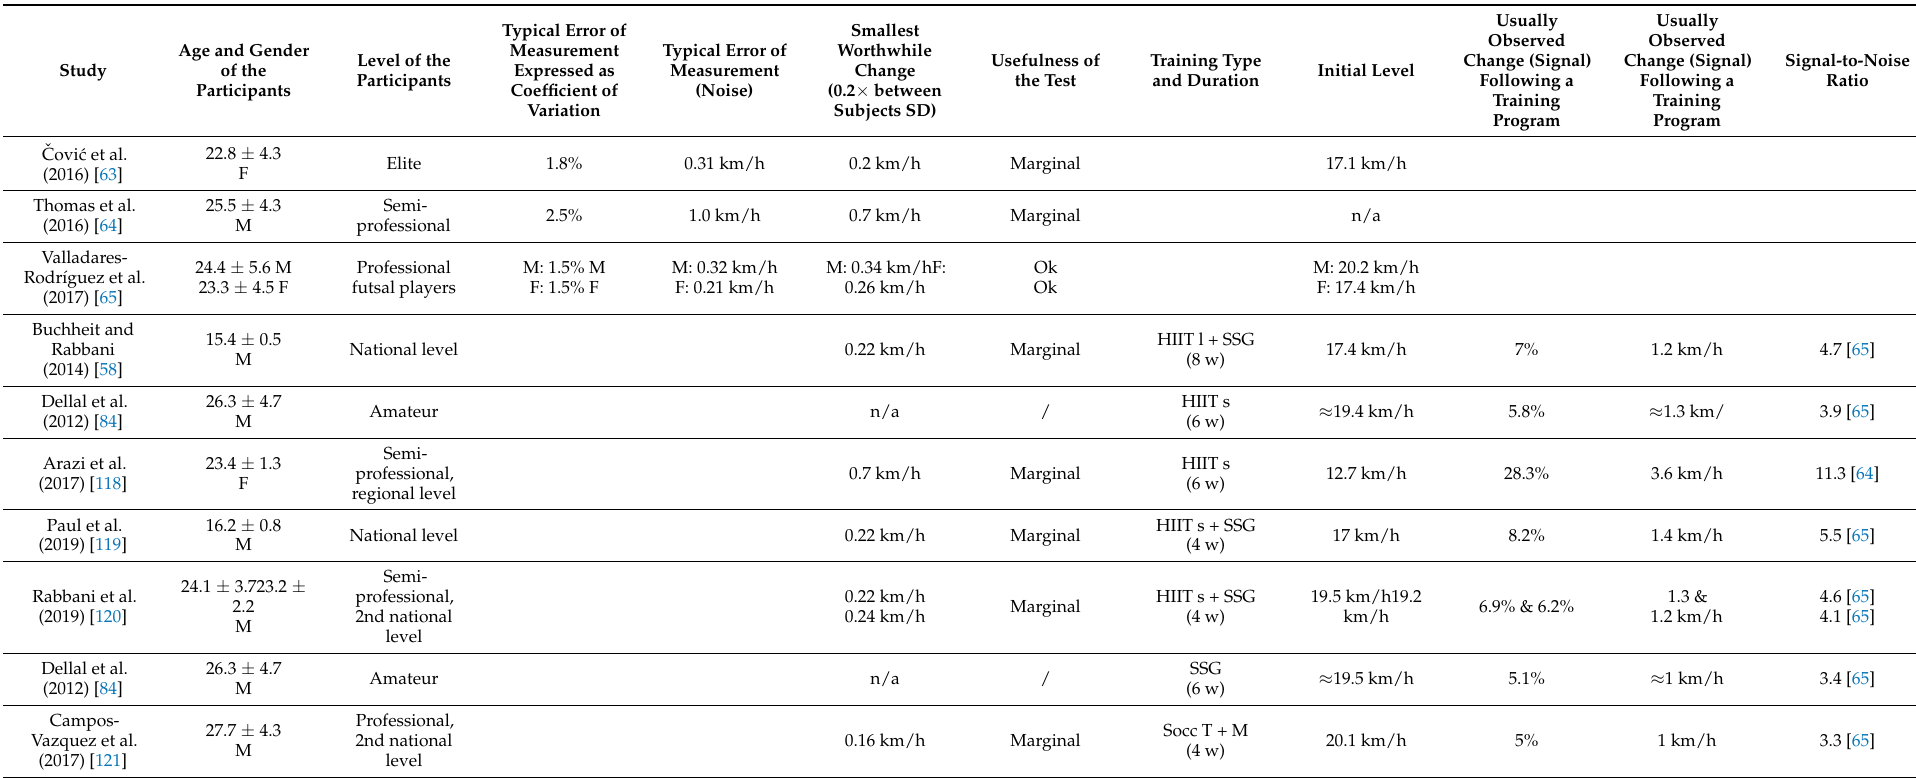
Table 5. Metric characteristics of the 30-15 intermittent fitness test extracted from studies conducted on soccer